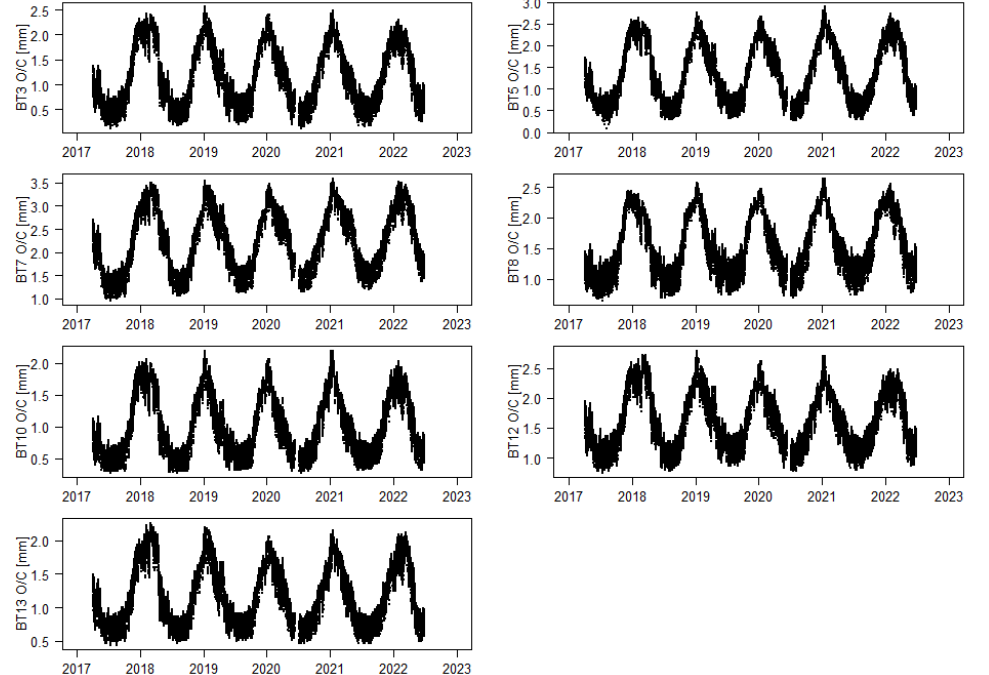
Figure 7. Time series of the relative movements between blocks measured between April 2017 and June